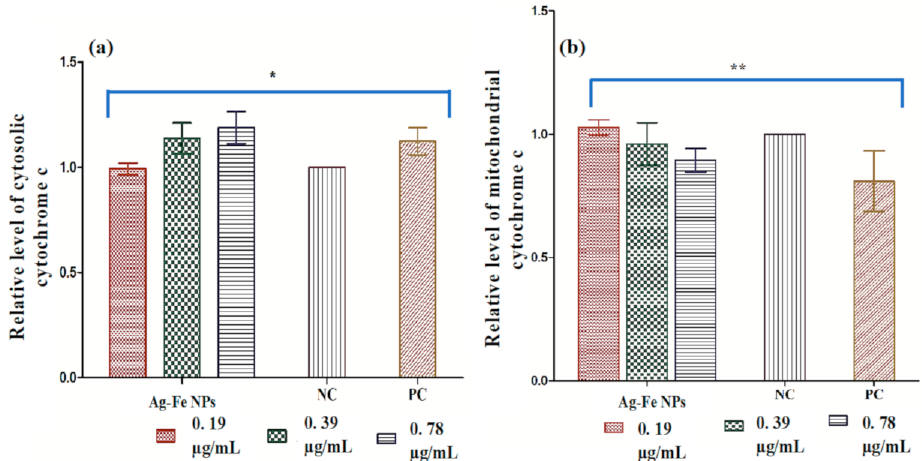
Figure 7. Activation of apoptotic factors in the C. auris MRL 6057 response to Ag–Fe NPs and H 2 O 2 (10 mM). ( a , b ) represent mitochondrial and cytosolic cytochrome c respectively. NC: negative control; PC: positive control. Ag–Fe NPs triggers PS externalization in C. auris. * p ≤ 0.001; ** p ≤